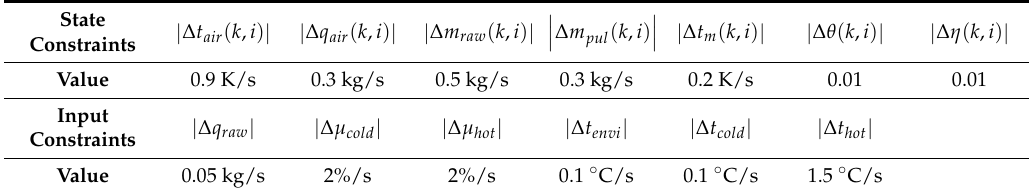
Table 5. State estimate